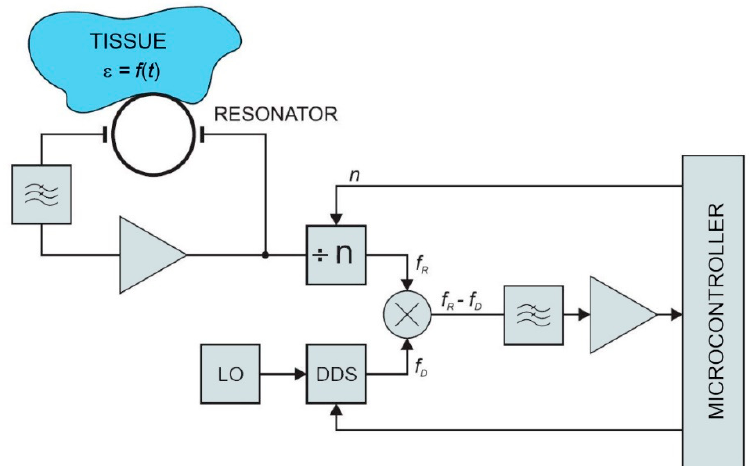
Figure 1. Large tuning range resonant sensor. LO is a local oscillator, DDS is a direct digital syn- thesizer, ÷ n is a frequency divider,  is tissue permittivity, n is the mode number, f D divider fre- quency, and f R is resonant frequency. is resonant